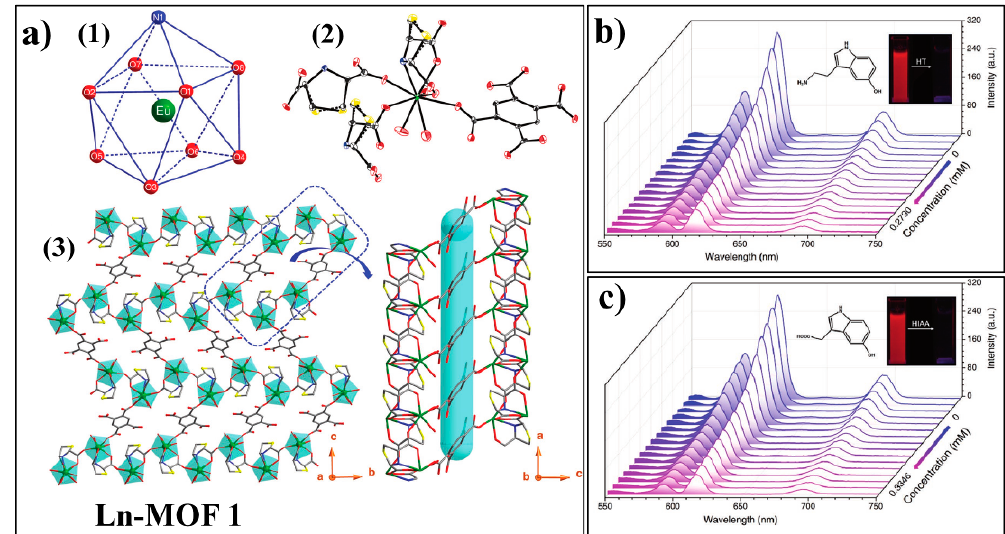
Figure 17. ( a ) structure of Ln-MOF 1: (1) Coordination geometry of the Eu 3+ ; (2) The asymmetric unit of Ln-MOF 1; (3) 3D framework composed of Ln-MOF 1. Atom codes: Eu (green), C (gray), N (blue), O (red), and S (yellow). Emission spectra of Ln-MOF 1 upon addition increase amount of ( b ) HT and ( c ) HIAA. Reproduced with permission from [124]. Copyright Wiley-VCH, 2018.